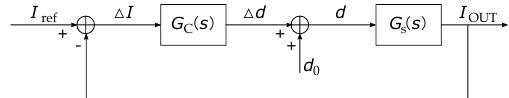
Figure 7. Closed-loop control diagram of the proposed converter with PI